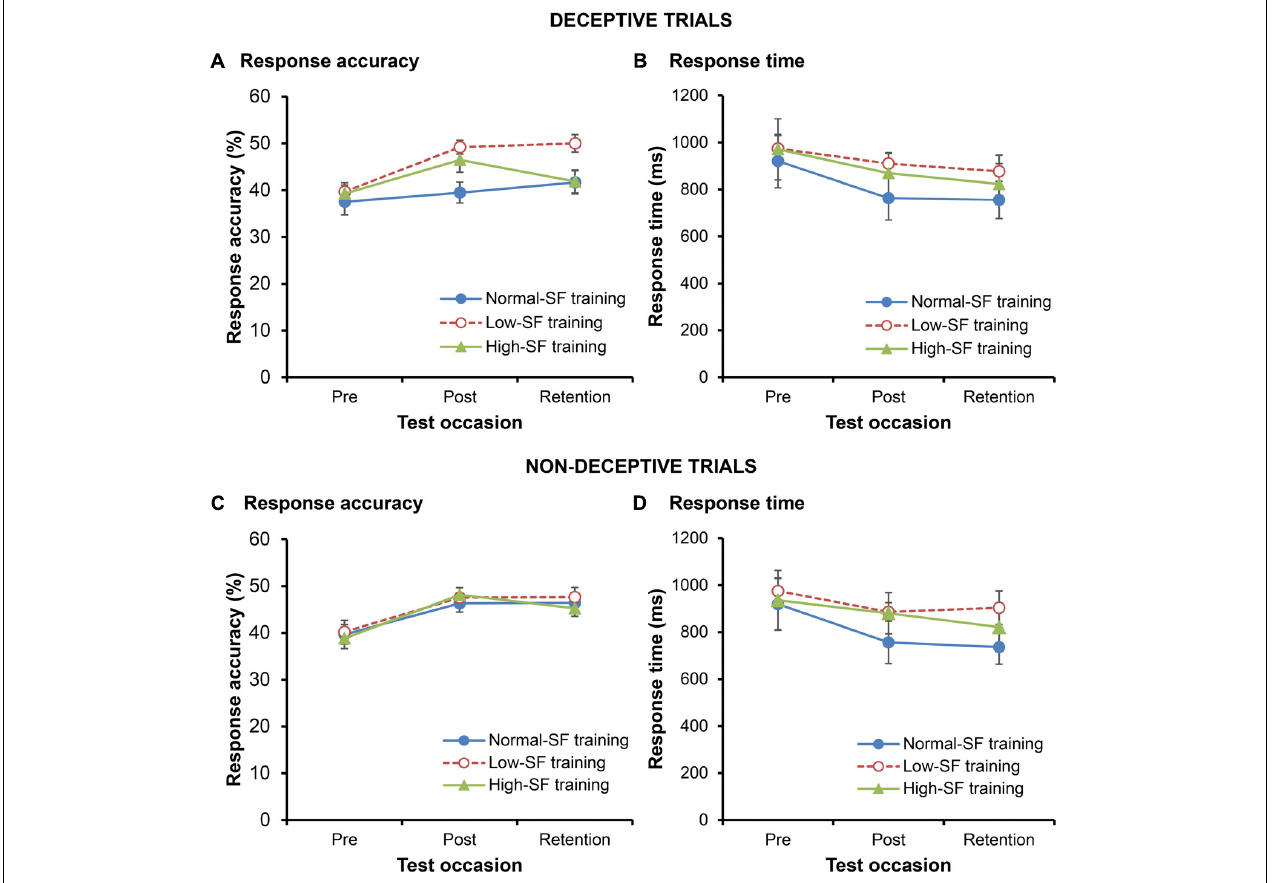
FIGURE 2 | Mean response accuracy and response time for deceptive (A,B) and non-deceptive (C,D) trials. Error bars indicate the standard error of the mean.